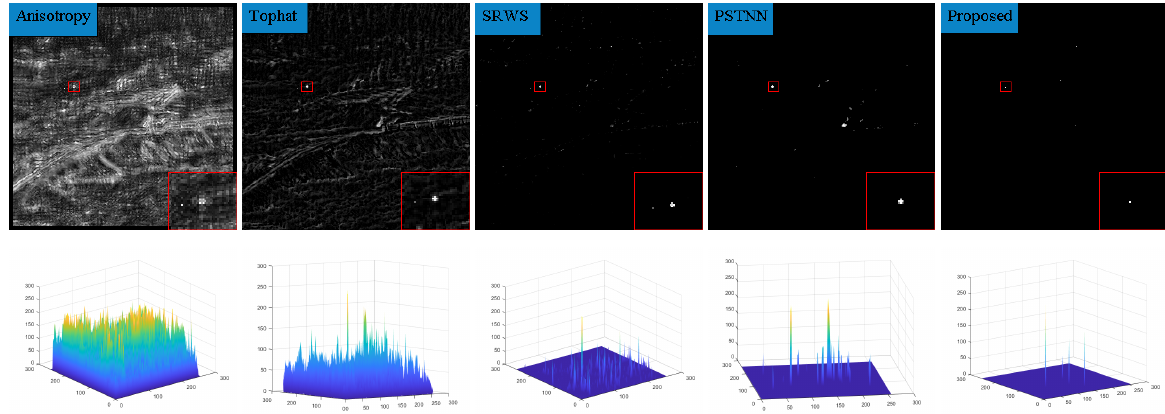
Figure 13. Detection results of sequence 5.